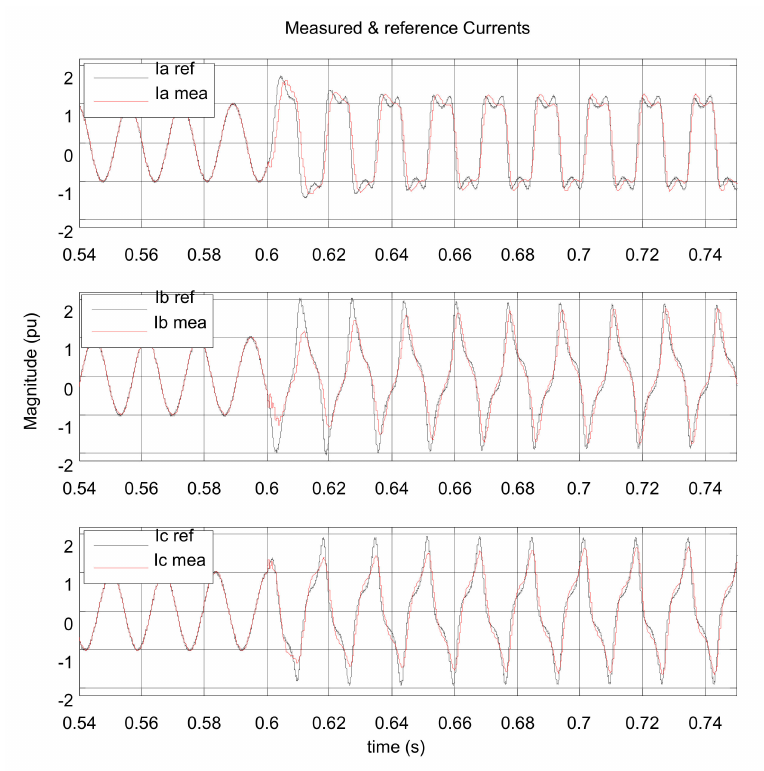
Figure 29. Current reference generated with IARC and grid current